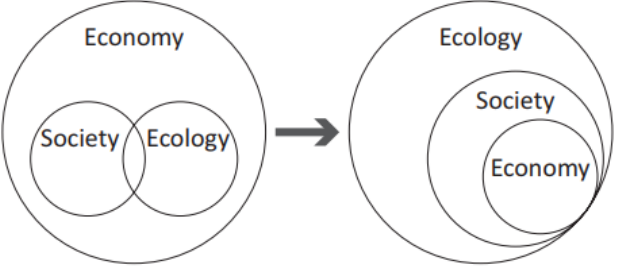
Figure 2. Changes in the concept of sustainability from the modernist paradigm to ecological thinking. Source: [20] (p. 56).